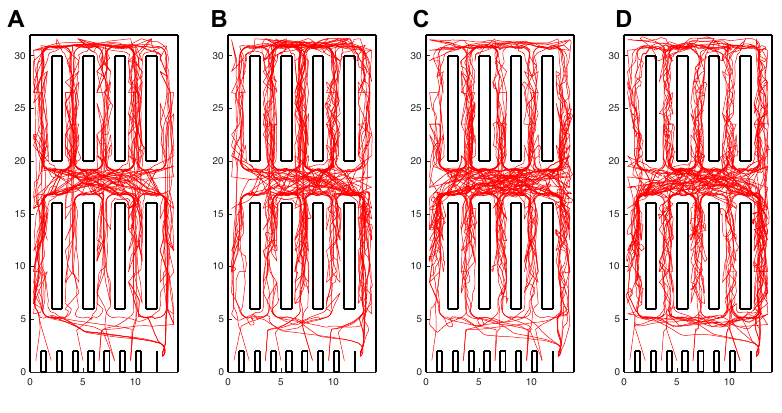
Figure 3: Ten random trajectories were chosen for different occupancies. A: N = 14, B: N = 35, C: N = 62, D: N = 92.